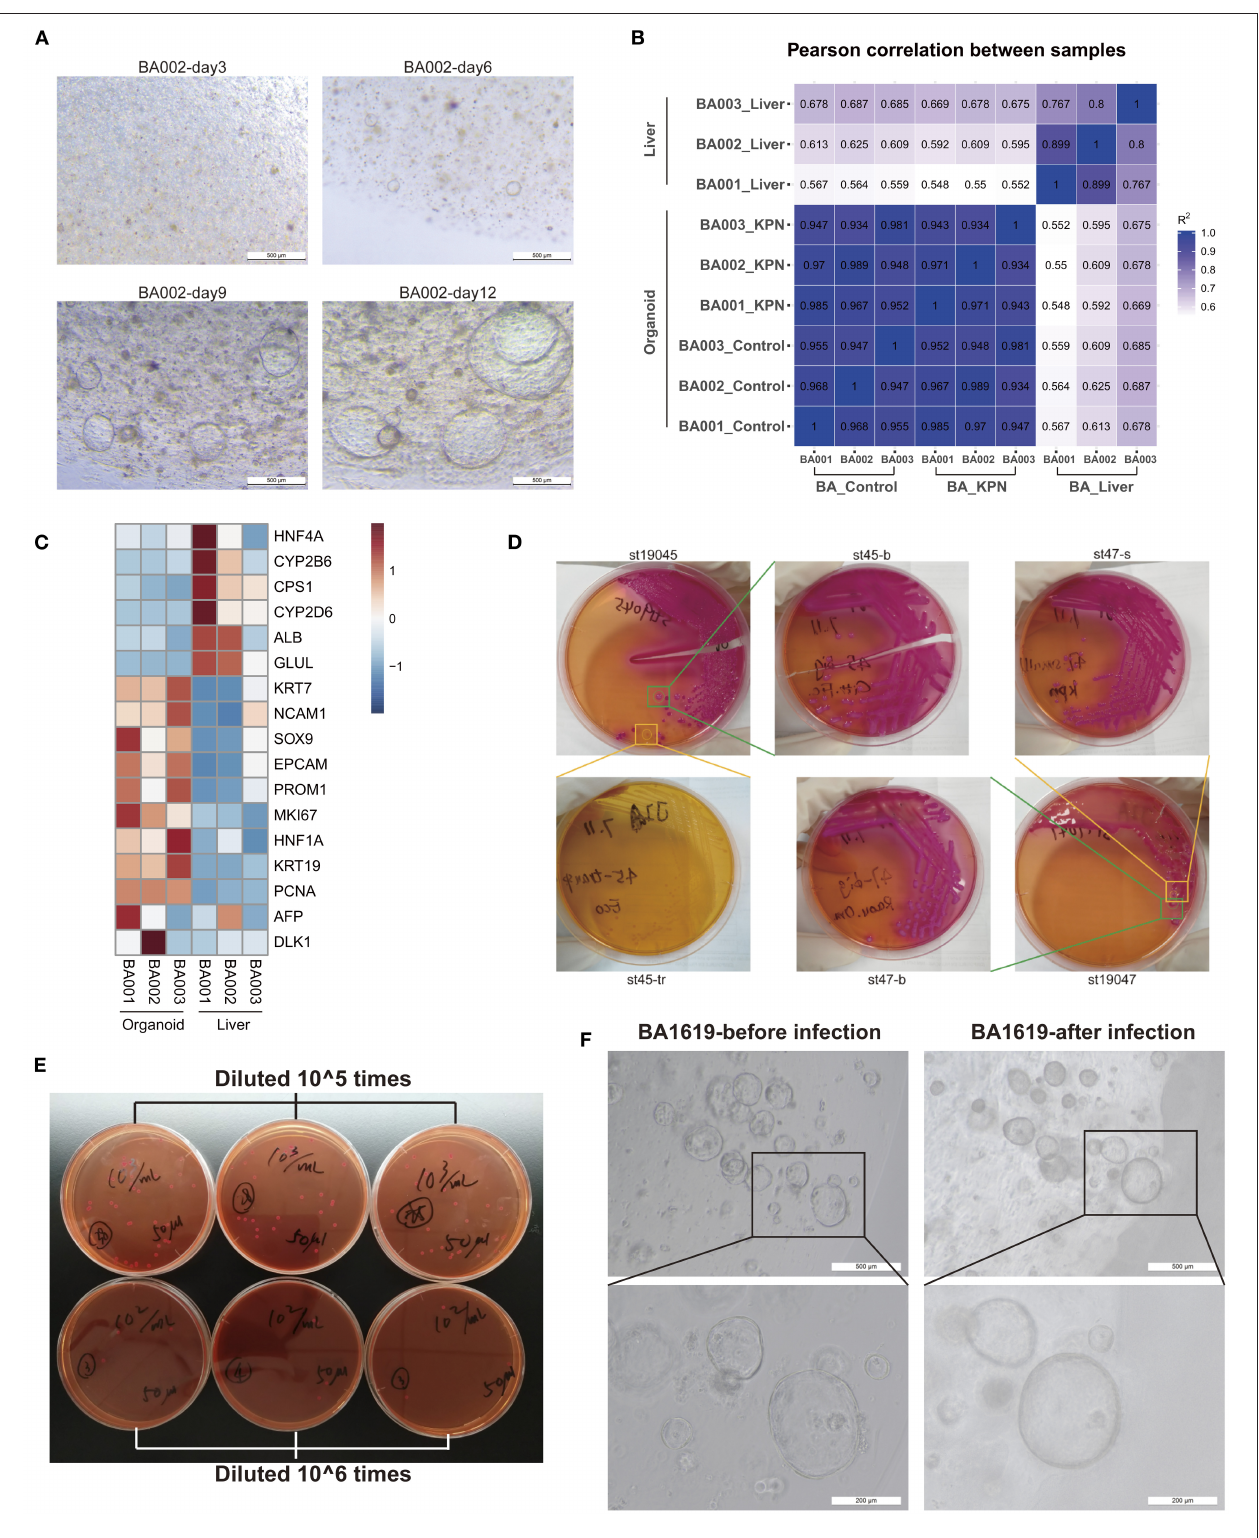
FIGURE 3 | Organoids may be an appropriate model for BA and post-Kasai cholangitis. (A) Culture of BA liver organoids. Small organoids began to appear during days 4–6 of culture and grew into large, mature, spherical organoids by days 10–12. (B) Pearson’s correlation test of three liver tissues, corresponding to